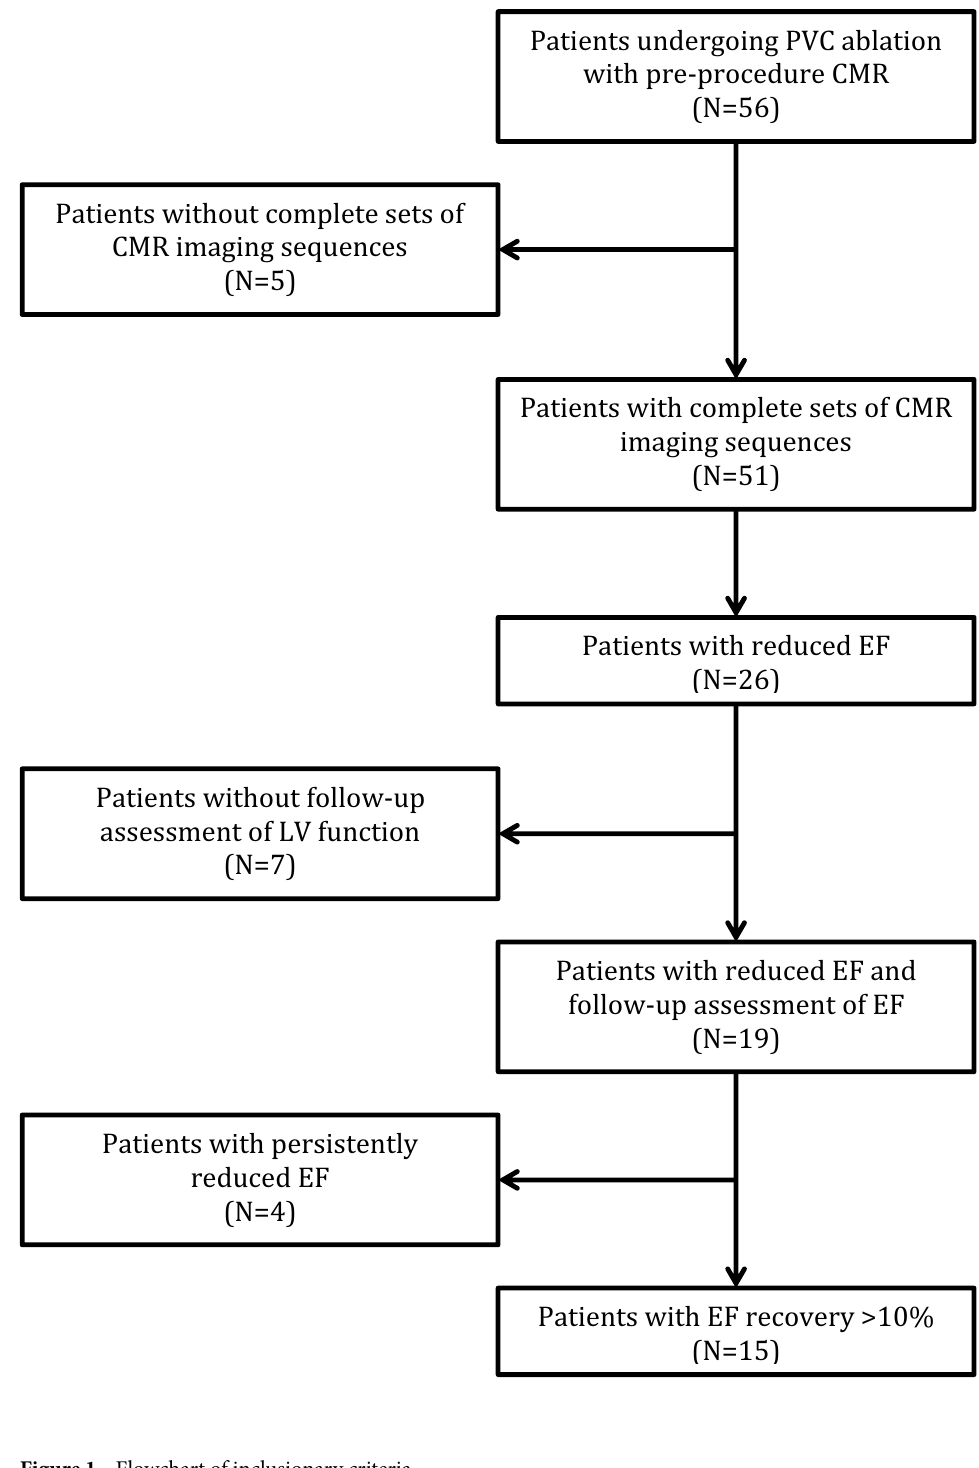
Figure 1. Flowchart of inclusionary